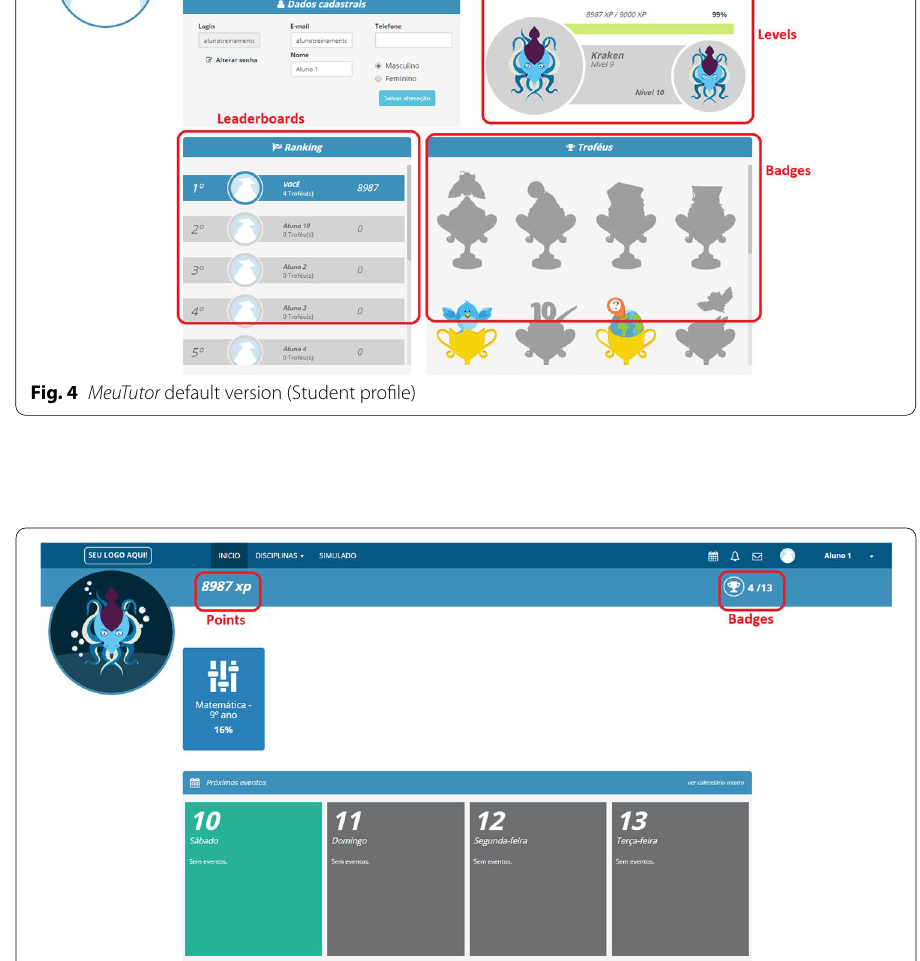
Fig. 5 MeuTutor achiever version